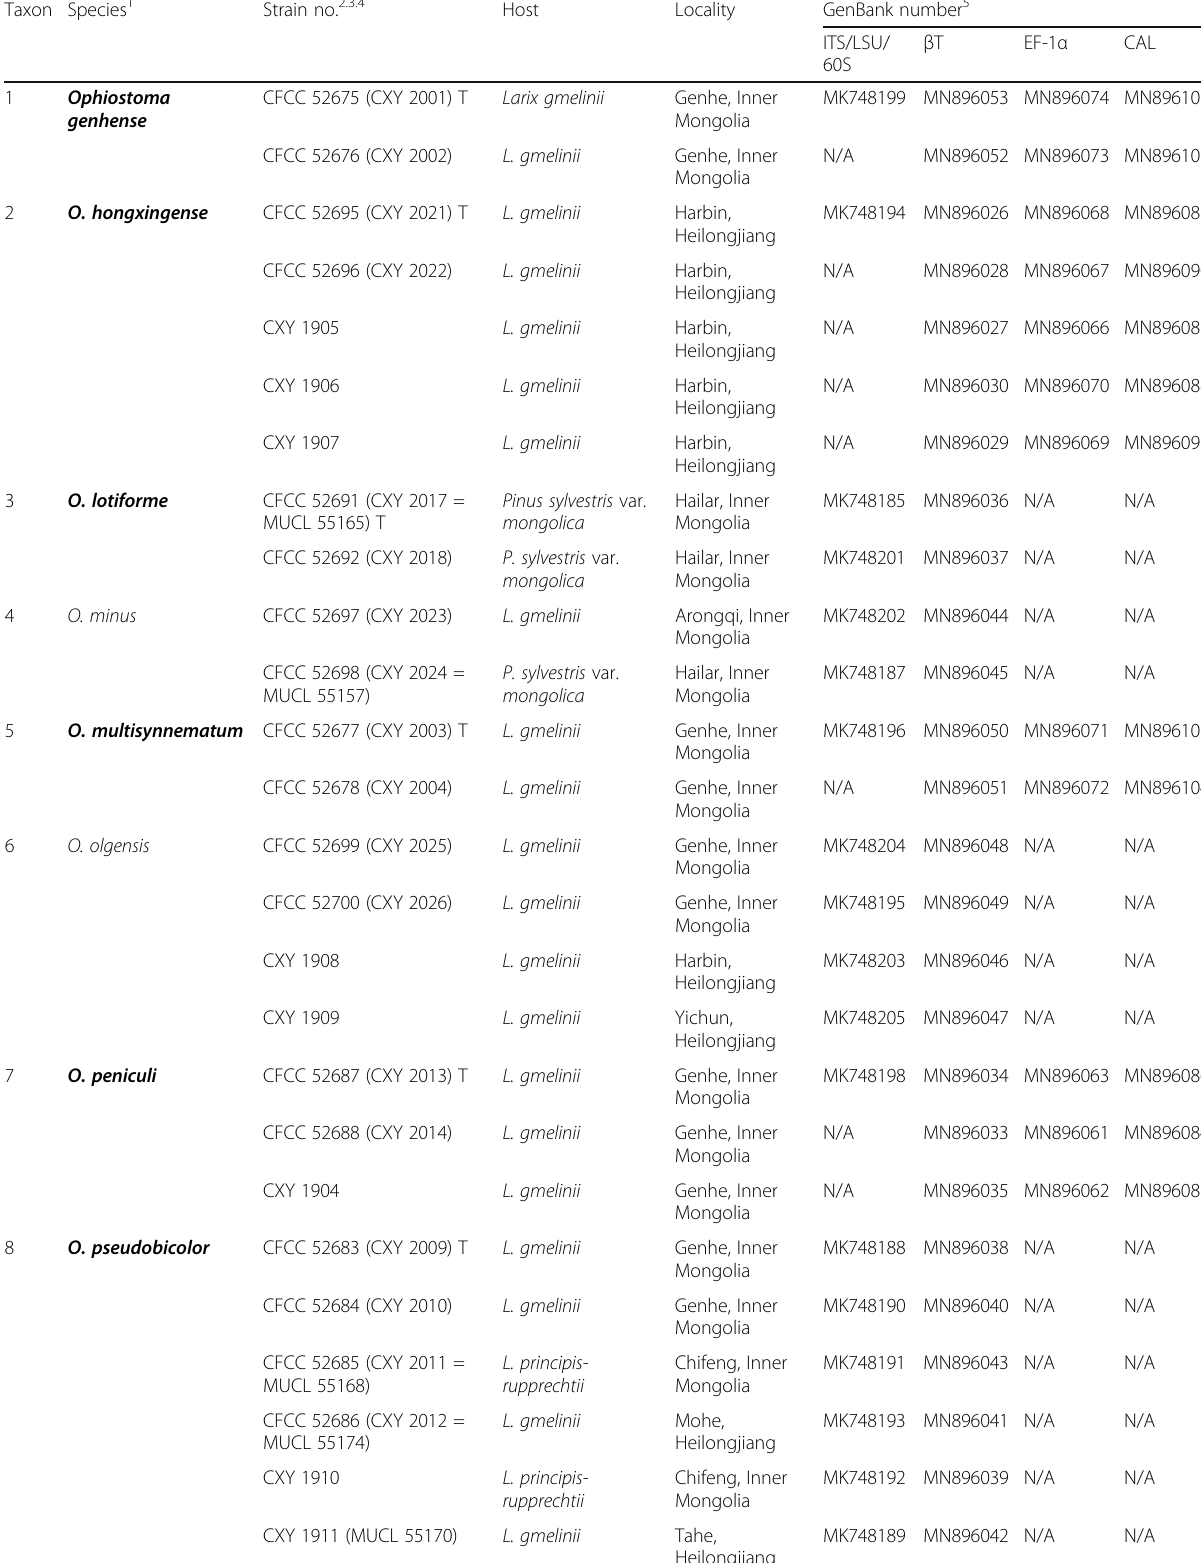
Table. 1 Strains of ophiostomatoid fungi sequenced and used for morphological and phylogenetic analysis in this study Taxon Species